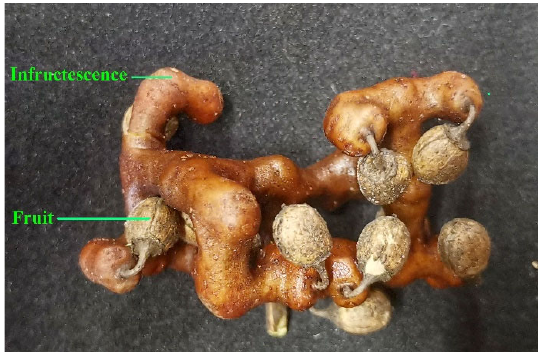
Figure 1. H. acerba infructescence and fruit.